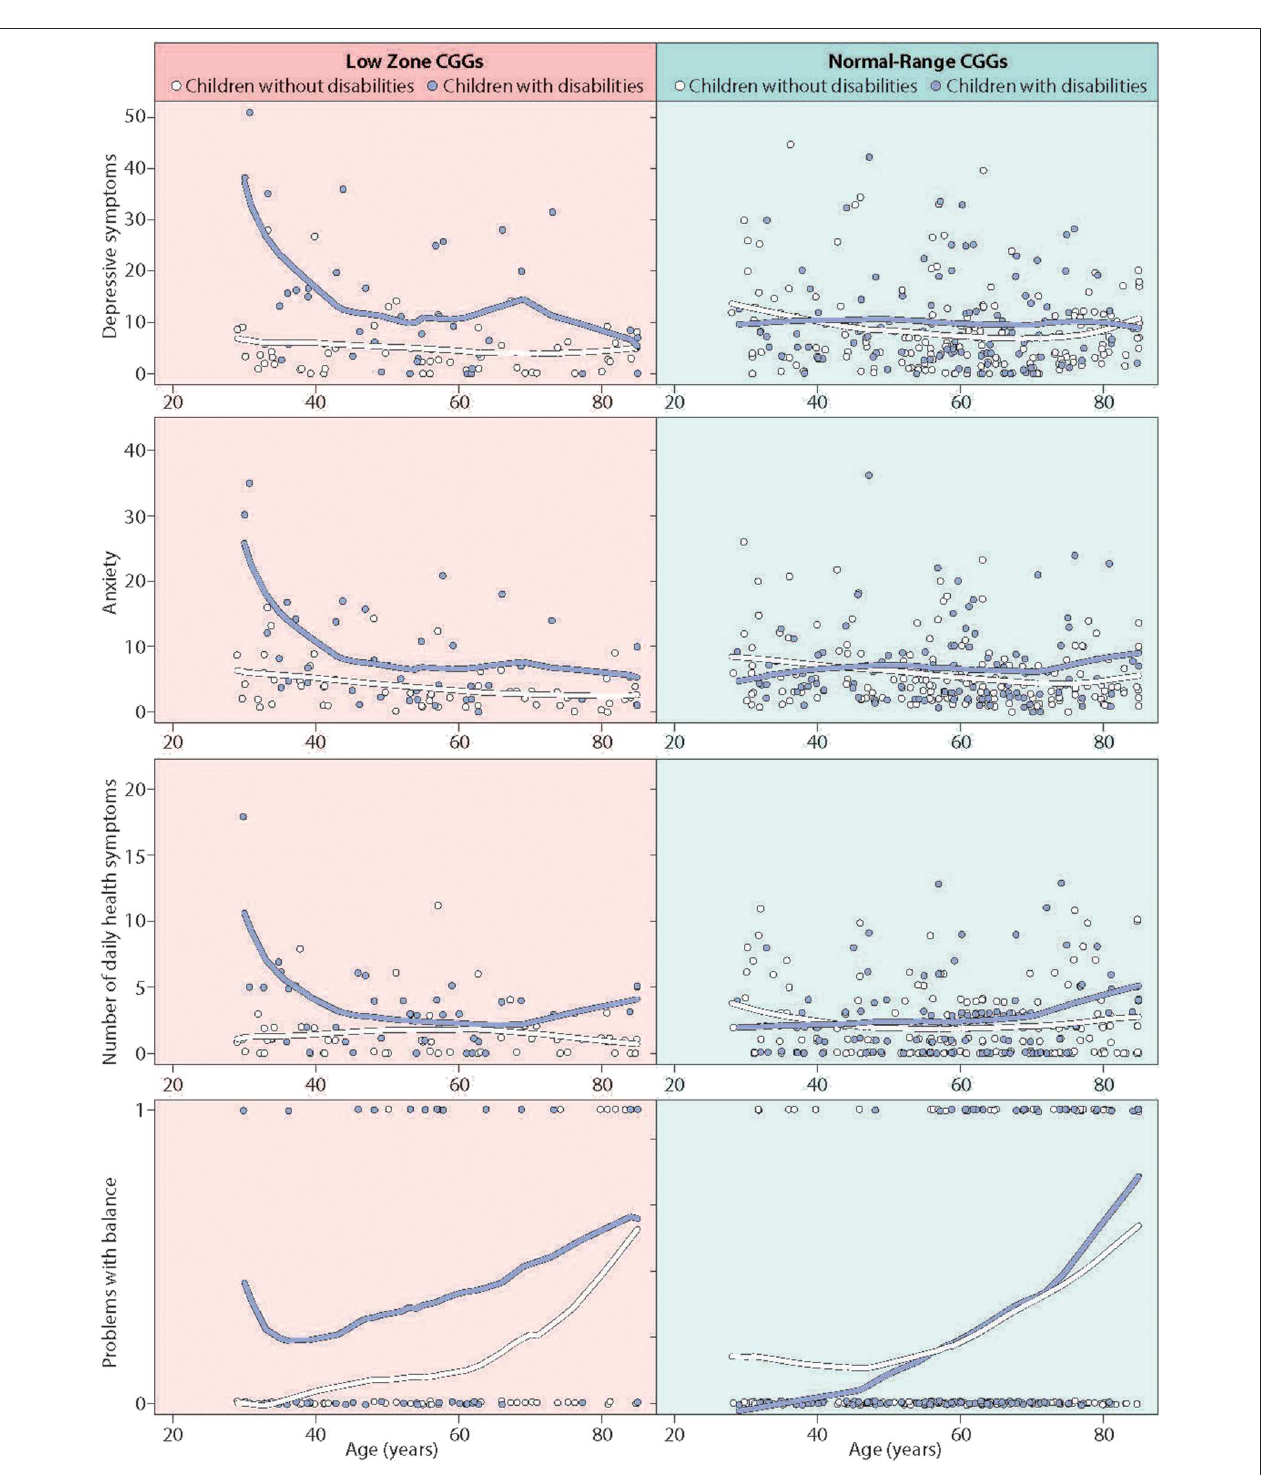
FIGURE 4 | Significant three-way interaction effects of age by stressful parenting status by CGG repeat category.